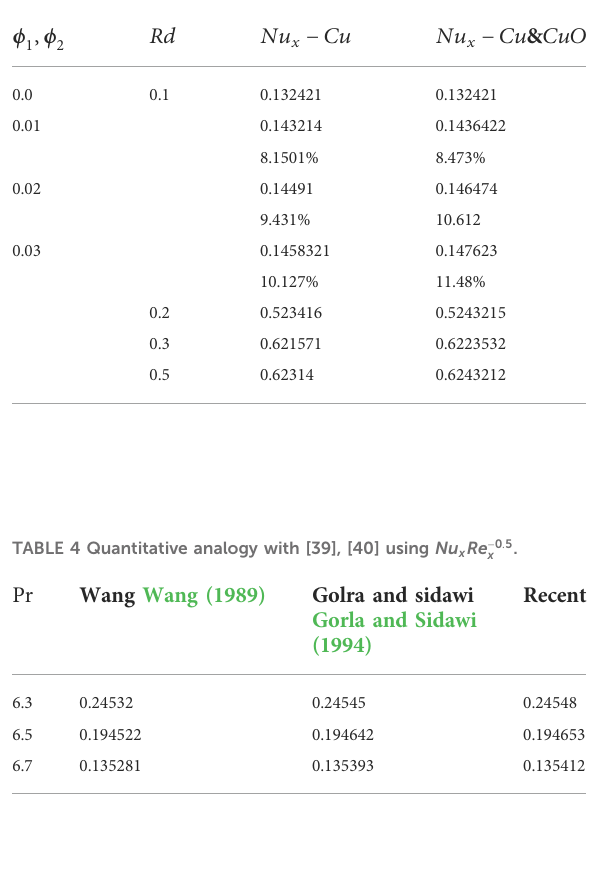
TABLE 3 Nu x Re − 0 . 5 x